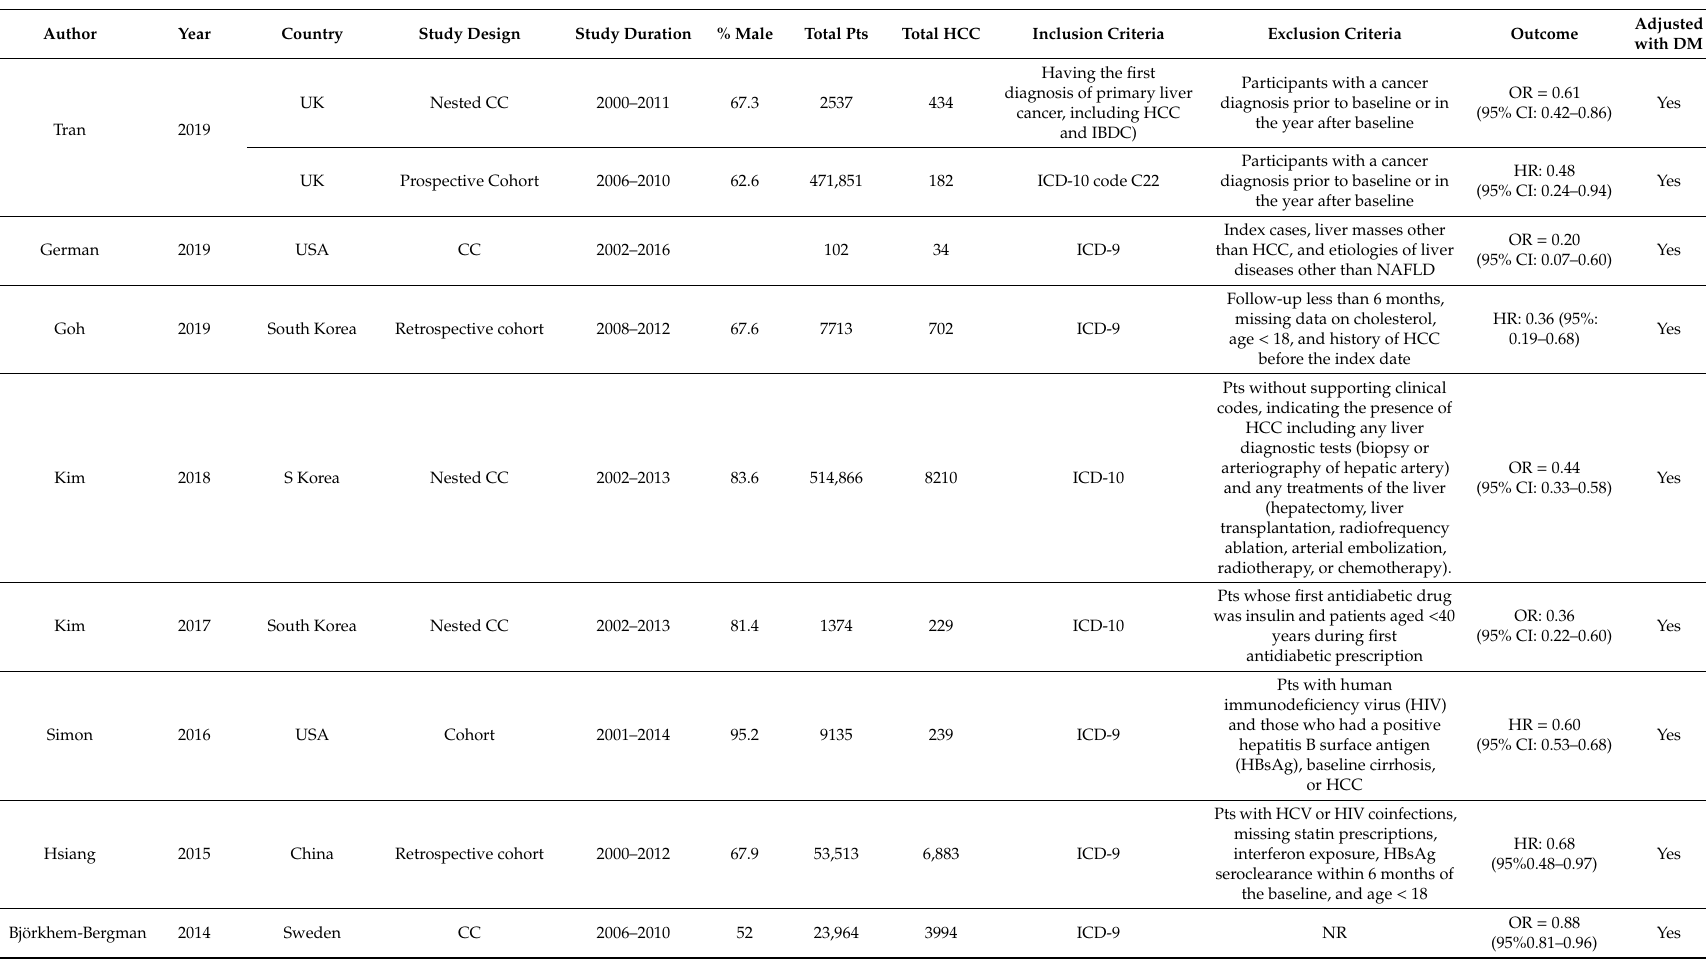
Table 1. Characteristics of included